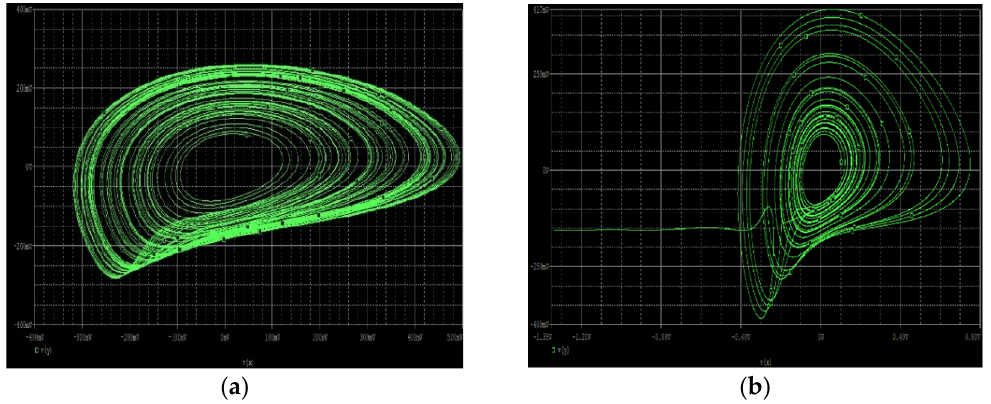
Figure 18. Simulation results of chaotic attractors and transient chaotic attractors: ( a ) R a 2 = 7.14 k Ω ; ( b ) R a 2 = 6.67 k Ω .